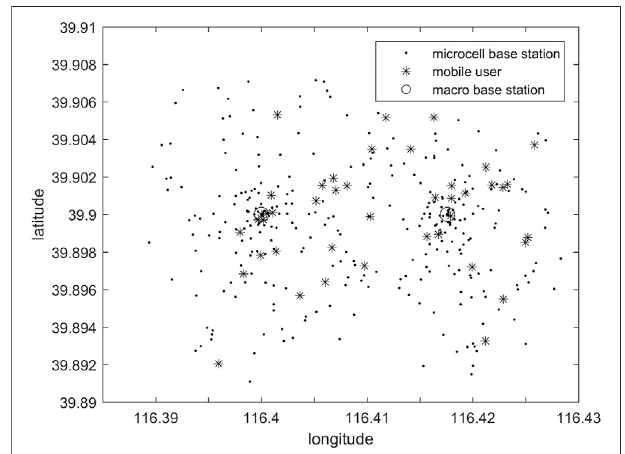
FIGURE 4 | The terrestrial environment